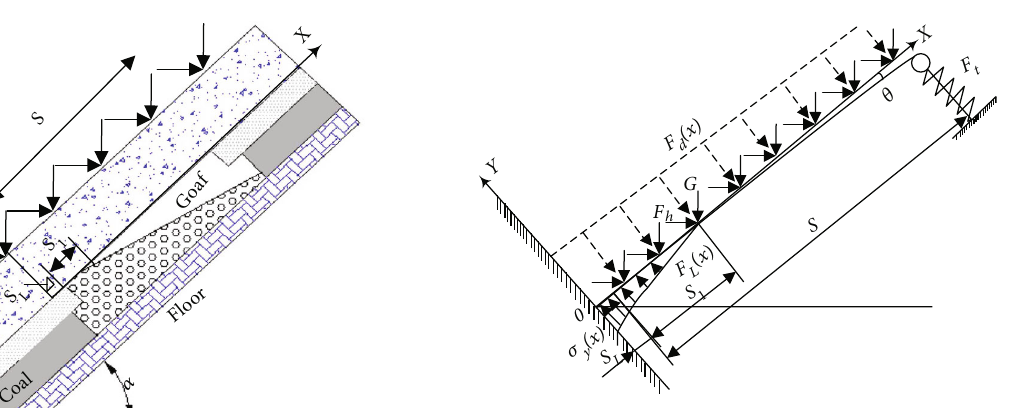
Figure 4: Mechanical model of inclined suspended roof